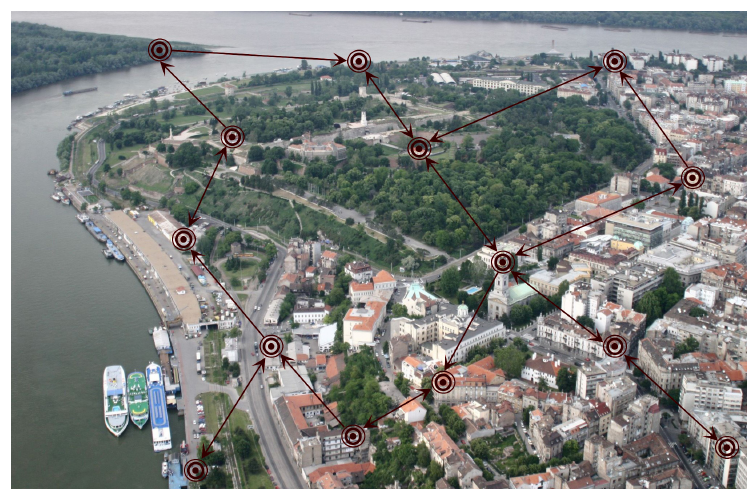
Figure 1. An example sensor network used in smart-city applications with decentralized communication topology. The inter-node communication is performed according to the depicted directed graph. The introduced distributed calibration algorithm achieves asymptotic calibration of all the sensor nodes in the network without using any type of fusion